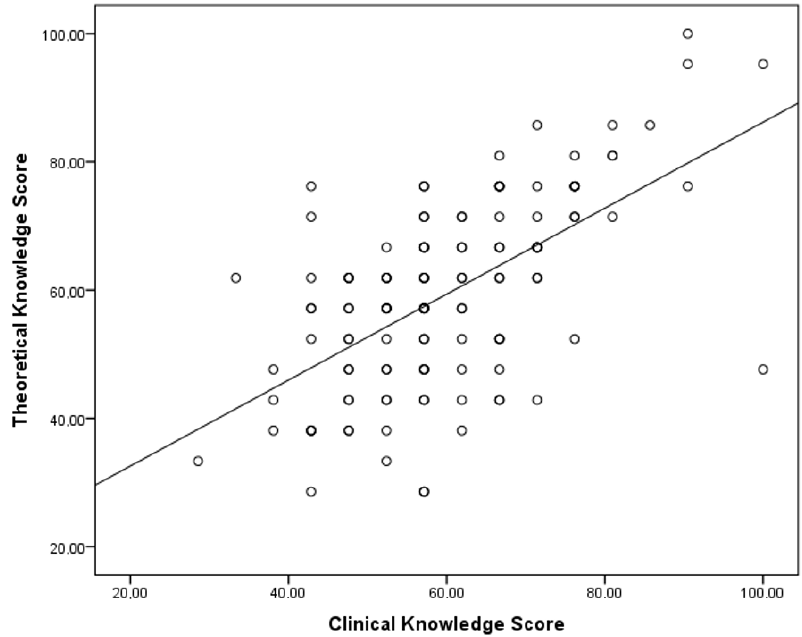
Figure 2. Correlation between theoretical and clinical knowledge